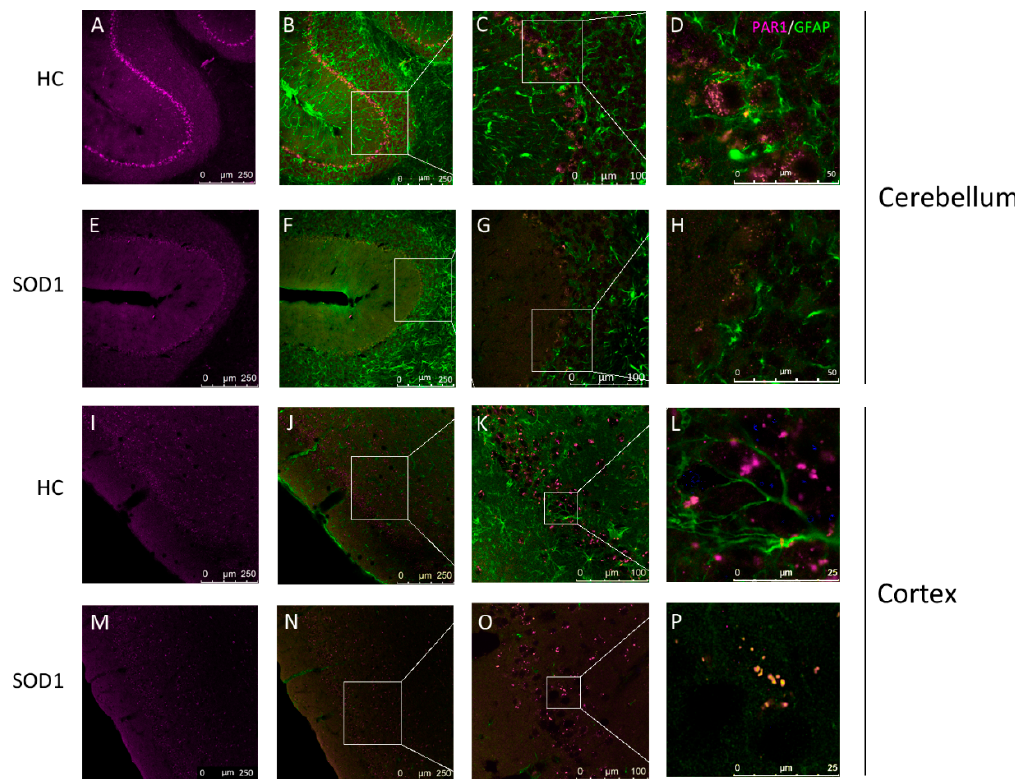
Figure 2. PAR1 localization in mice cerebellum and cortex: Confocal fluorescent microscopy immunohistochemistry with antibodies labeling PAR1 (magenta) and the astrocytic marker glial acidic fibrillary protein (GFAP, green) in ( A – H ) the cerebellum and ( I – P ) the cortex of healthy and SOD1 mice in × 20 magnification. Co-localization of PAR1 with GFAP is seen in pink. Further magnification of × 63 is shown in C,G,K,O. High power magnification of selected areas (indicated by white frames) are shown in D,H,L,P. SOD1 mice show reduced levels of PAR1, and disruption of its co-localization with GFAP, as was indicated by qualitative analysis. Reduction of GFAP staining suggests astrocytic morphological modification. Immunohistochemistry was performed at the age of 20 weeks. All photos had color adaptation using Adobe Photoshop CS5. Number of animals: SOD1 n = 3, healthy control n =